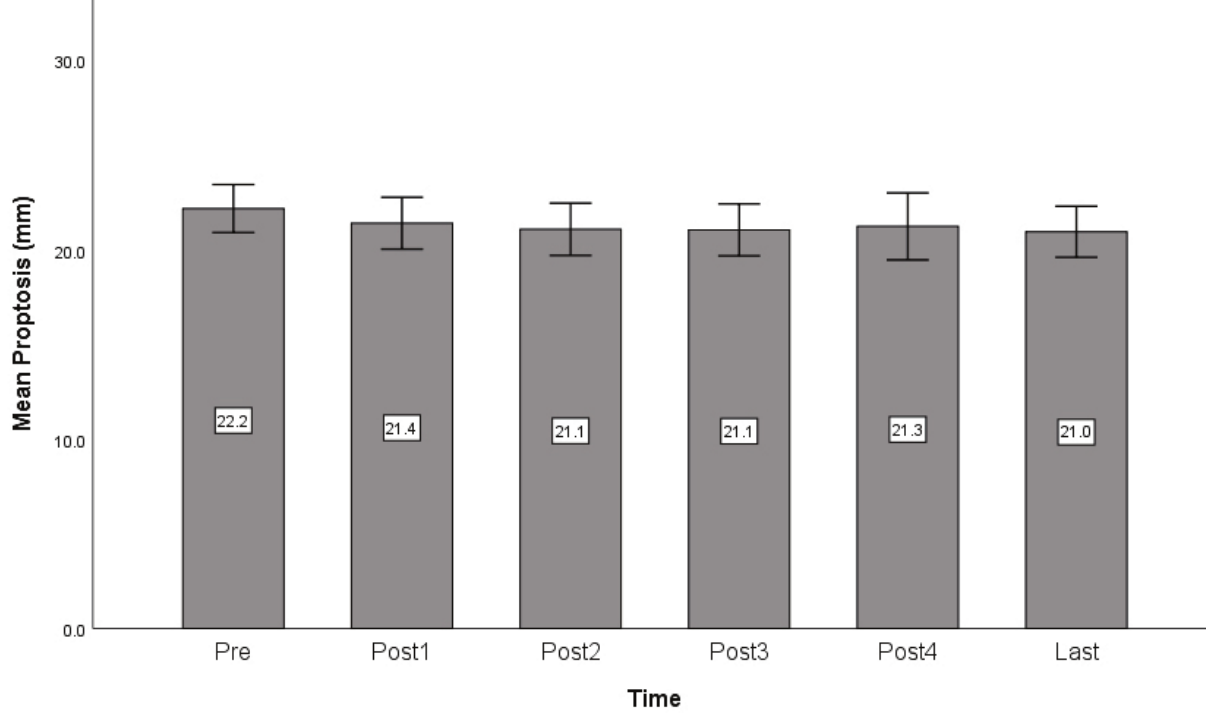
Figure 3. Bar diagram of changes in mean amount of proptosis before the injections up to the final